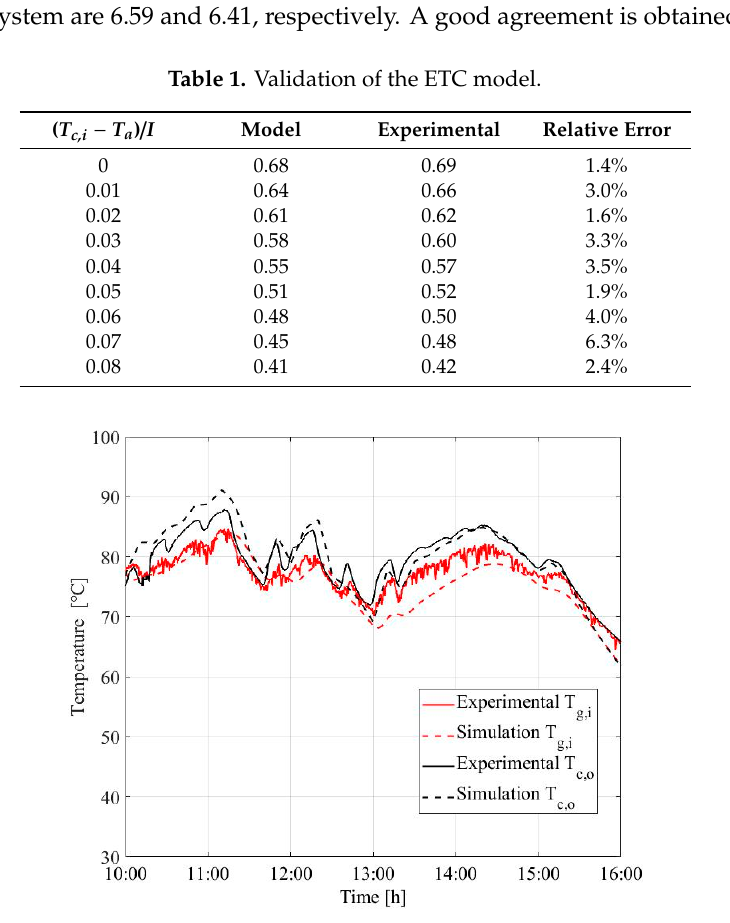
Figure 2. Validation of SASCHCS.